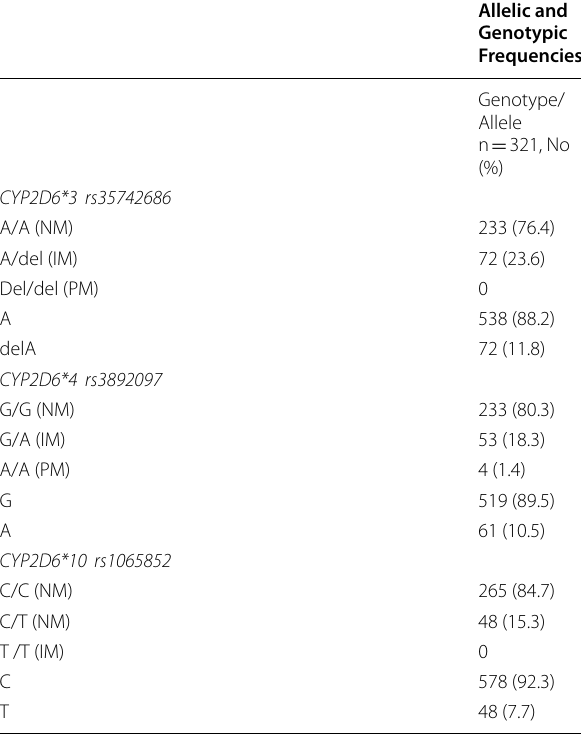
was found between CYP2D6*4 and CYP2D6*10 SNP, as shown in Fig. 2.